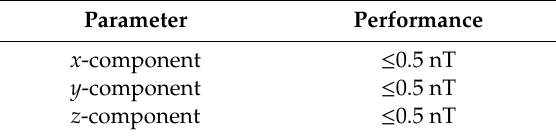
Figure 5. The calibration results. ( a ) The x component; ( b ) The y component; ( c ) The z component. Table 2. Calibration result of simulation experiment.